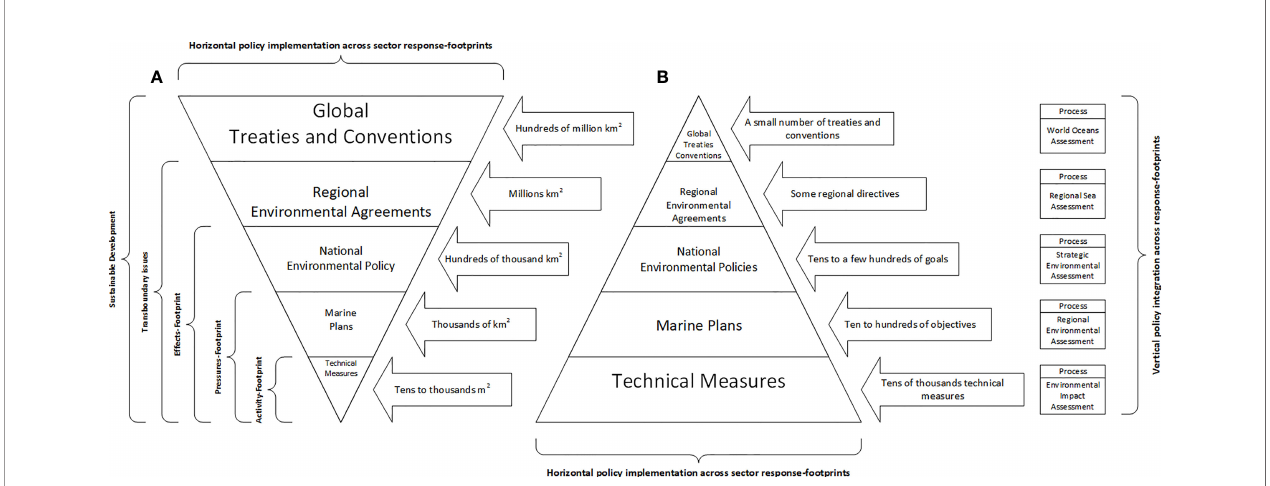
FIGURE 2 | The ‘ management response-footprint pyramid ’ – showing both (A) the areas covered by management response-footprints and (B) the number of policy instruments; horizontal and vertical policy integration is also